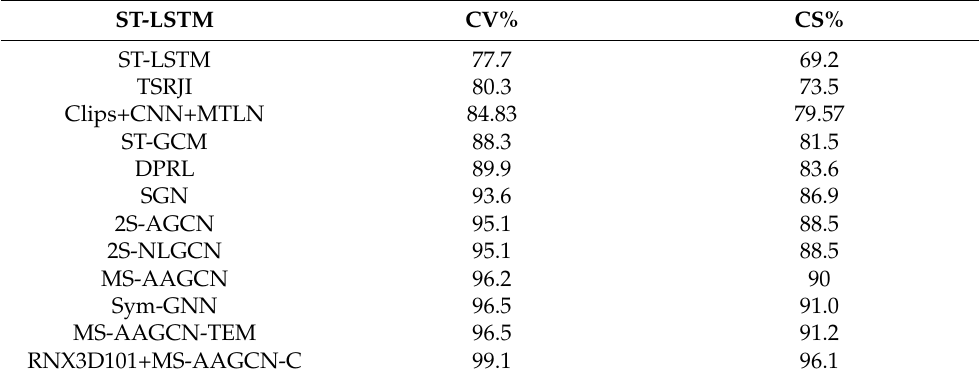
Table 4. Comparison of 3D-based recognition methods in NTURGB-D. ST-LSTM CV%